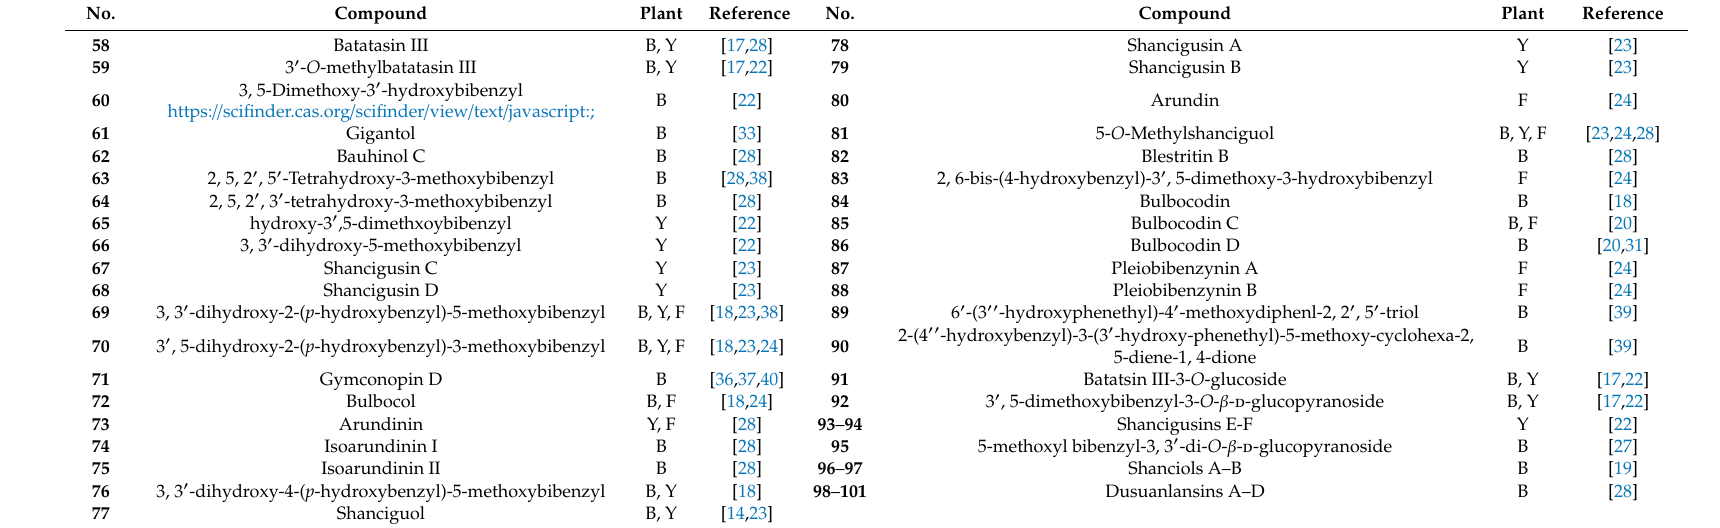
Table 4. Bibenzyls from Pleione